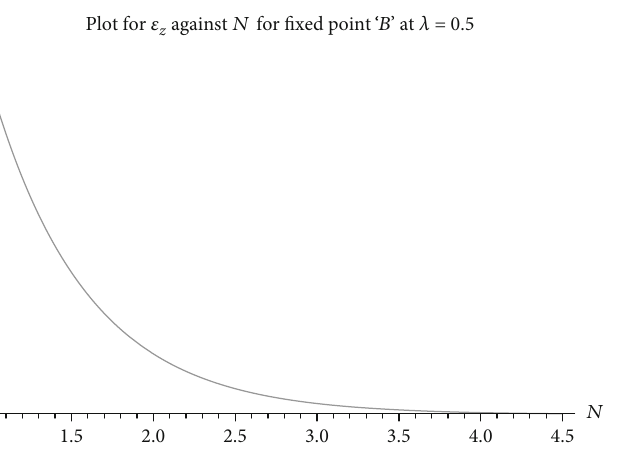
against N at λ = 0 : 5 for fi xed point B . z